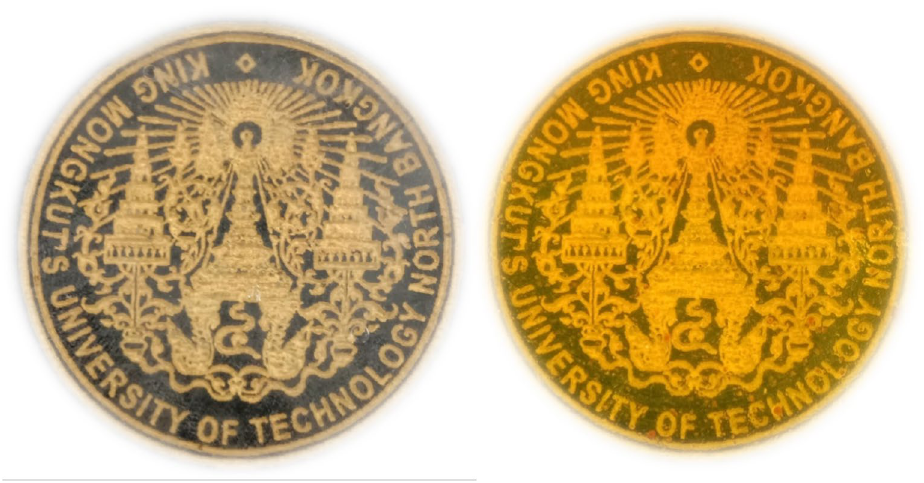
Figure 2. Photographs of plain PVA/CMC and PVA/CMC/TUR